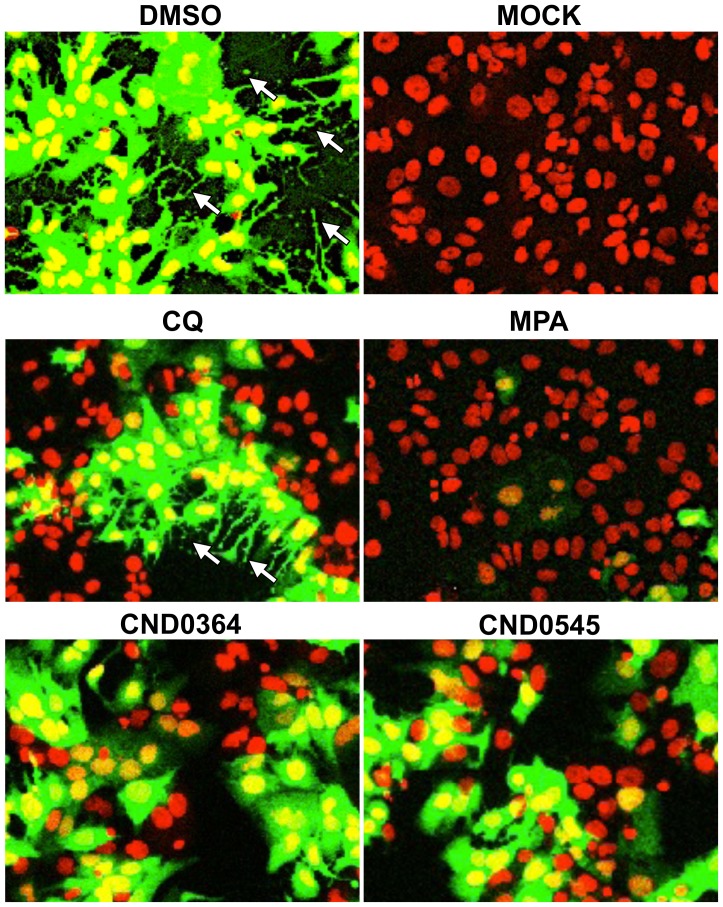
Inhibition of CHIKV-associated apoptotic bodies.HuH-7 cells infected with CHIKV-118-GFP expressing GFP at 24 hpi. The number of observed apoptotic blebs associated with CHIKV infection (marked by white arrows) were significantly lower when treated with the reference compound MPA and hit compounds CND0364 and CND0545. In contrast, apoptotic blebs were still prominent in CHIKV-infected HuH-7 cells in the presence of CQ. (false-color imaging were applied).